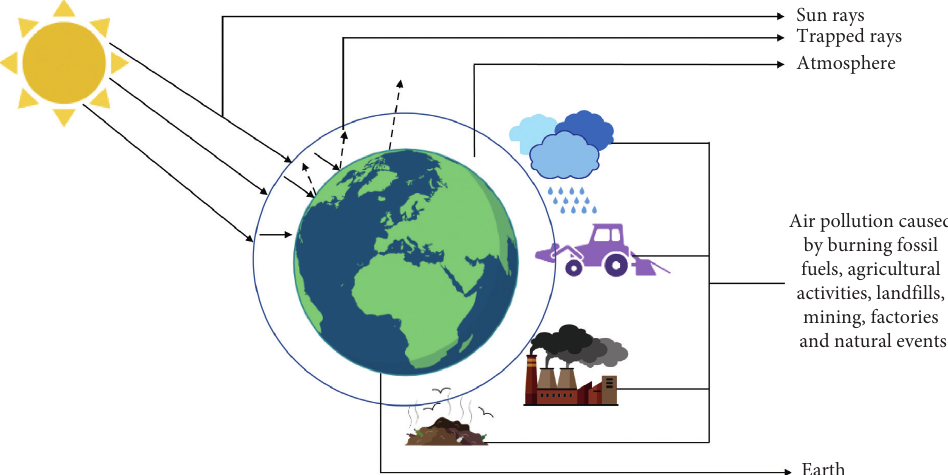
Figure 1: Simple representation of the greenhouse effect. The main drivers of air pollution: burning of fossil fuels and industrial and agricultural activities. These events trap more of the sun’s radiation in the atmosphere resulting in global